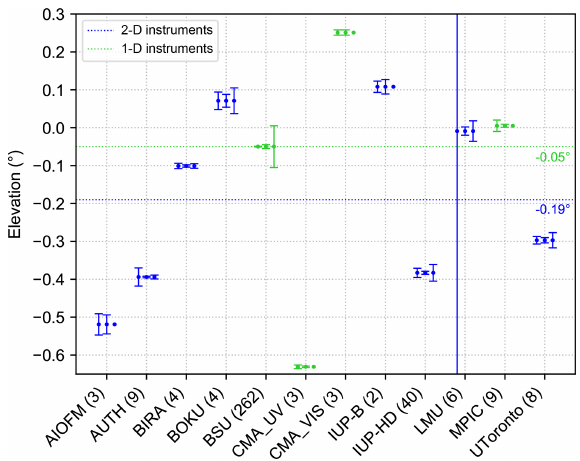
Figure 14. Overview of the retrieved lamp elevations for the 2-D and 1-D instruments including different measures of their uncer- tainty, mean of fit errors (left), error of the mean (middle) and daily spread (right). The number of available lamp scans for each instru- ment is displayed in brackets after the individual institute acronyms. The expected lamp elevations are indicated by the corresponding dashed lines.